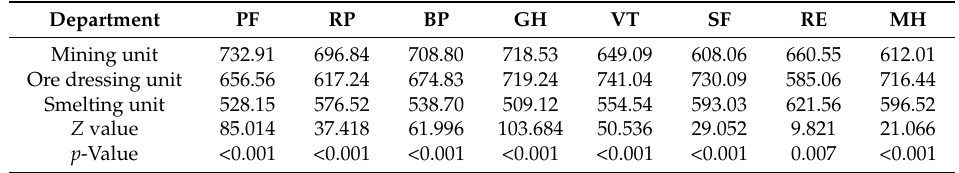
Table 4. Comparison of the quality of life of copper and nickel miners working in mining, ore dressing, and smelting units.